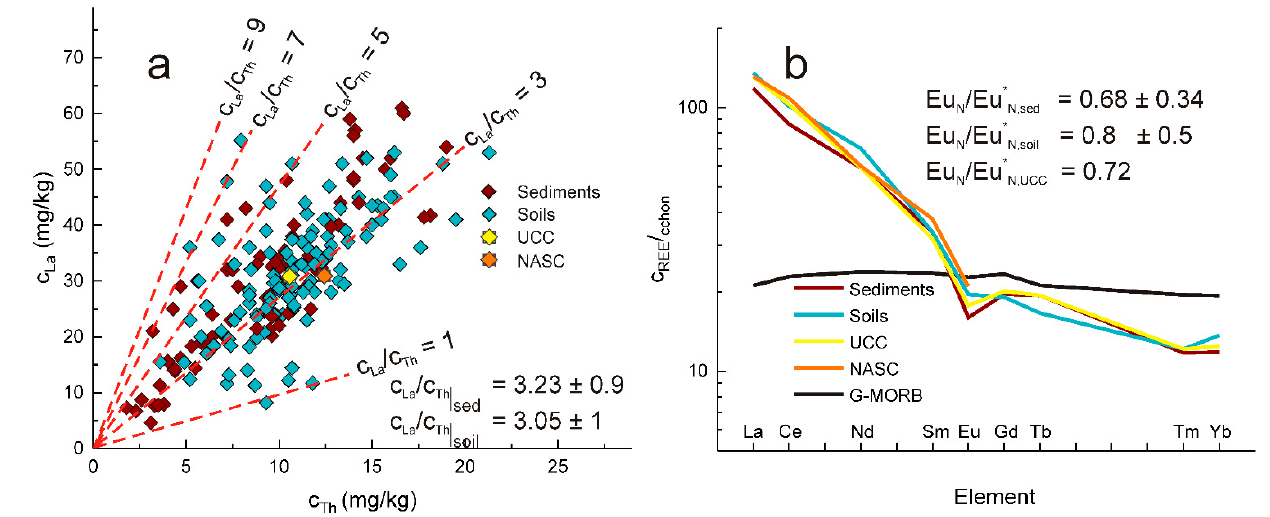
Figure 7. The La vs. Th bi-plot ( a ) proving that both Zarafshon sediments and soils are significantly closer to UCC [17] and NASC [18] than to MORB [51,52] as well as the eight REE average values of Zarafshon sediments and soils normalized to chondrite [53] together with the corresponding UCC data ( b ) [16]. Table 3. The La/Sm, Gg/Yb, Eu* as well as the Th/U values for sediments and soils. For comparison, the same ratios corresponding to UCC [17] and NASC [18] are reproduced too.